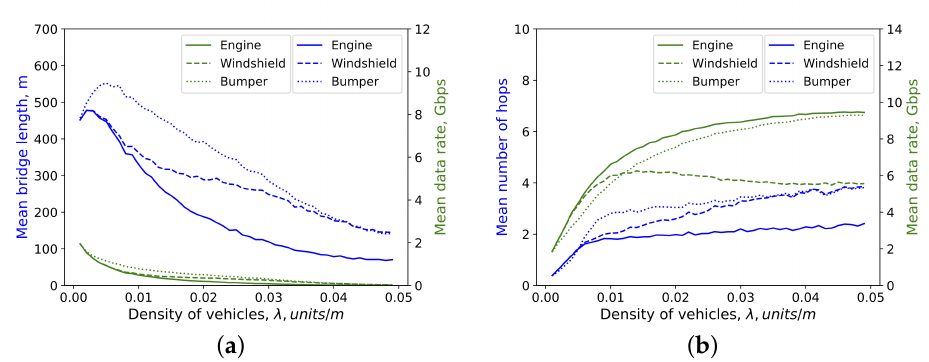
Figure 5. Trade-off between the considered metrics. ( a ) bridge length vs. data rate; ( b ) number of hops vs. data